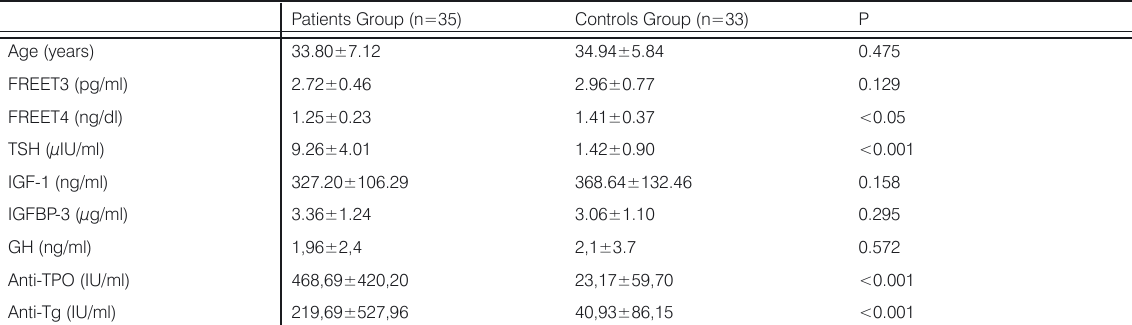
Table 1. Thyroid hormones, IGF-1 and IGFBP-3 levels in subclinical hypothyroid group and healthy controls. Values (means ± SEM) and statistical significance of the analyzed